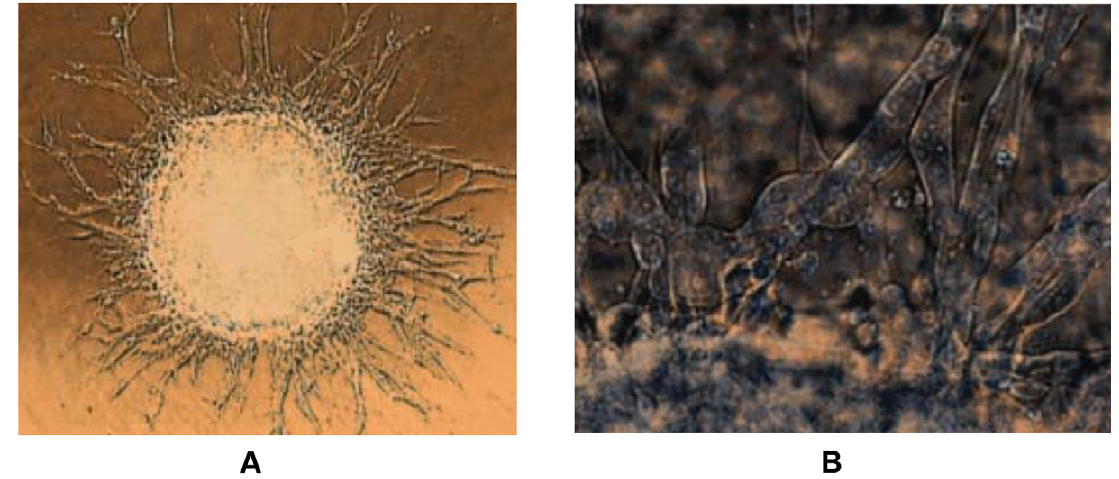
Figure 1. GBM multicelluar tumor spheroid (MTS) gel assay showing dendritic invasive branches. (a) The invasive branches centrifugal evolve from the central MTS. The linear size of central MTS is approximately 400 m m . (b) The invasive branches are composed of chains of invasive cells. The images are adapted from Ref. [4].